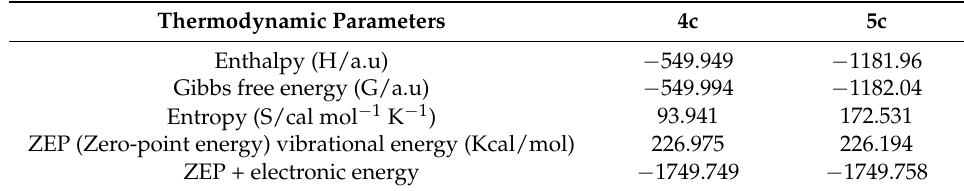
Table 9. Ground state energies (enthalpy, Gibbs free energy and entropy) calculated for 4c and 5c